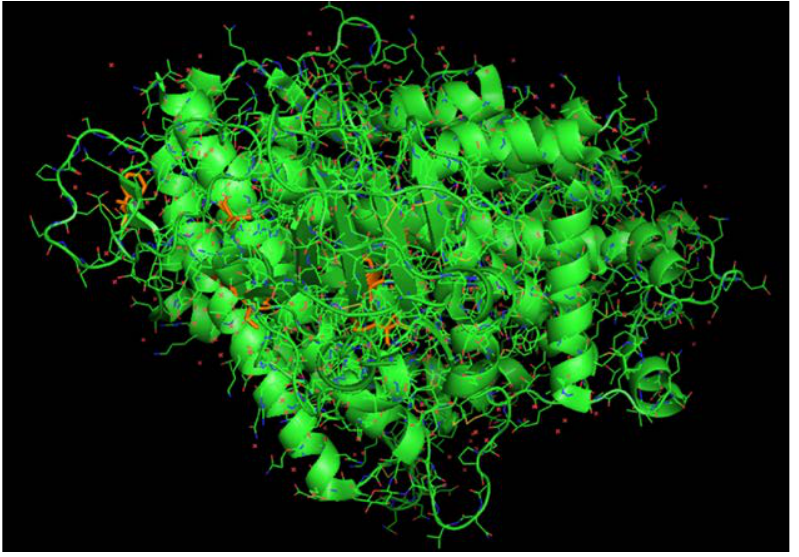
Fig. 3. Tertiary structure of N-protein of